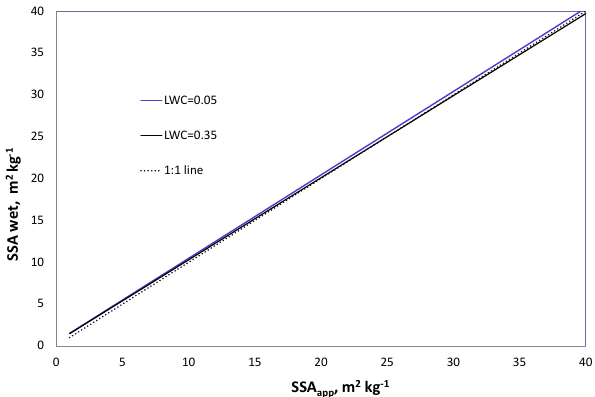
Figure 7. Relationship between the apparent SSA of a wet snow sample determined with DUFISSS using dry fit and that of the same sample whose SSA has been corrected according to Eq. (8), which takes into account reflectance and expansion effects. Calculations have been done for two realistic LWCs of snow.